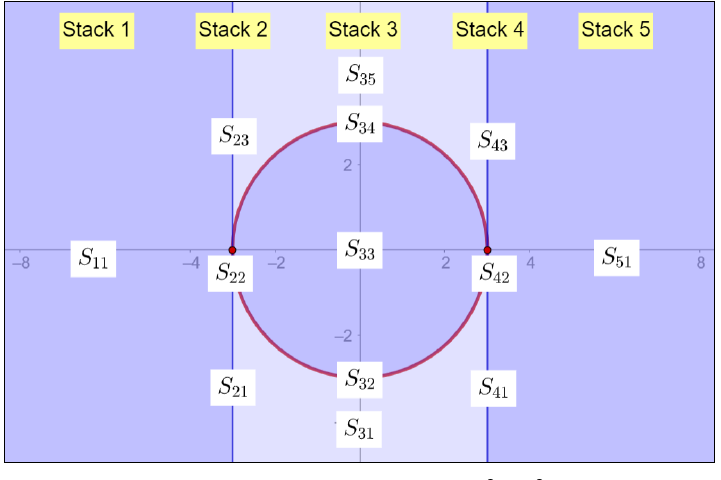
Figure 4. CAD compatible with the polinomial x 2 + y 2 −